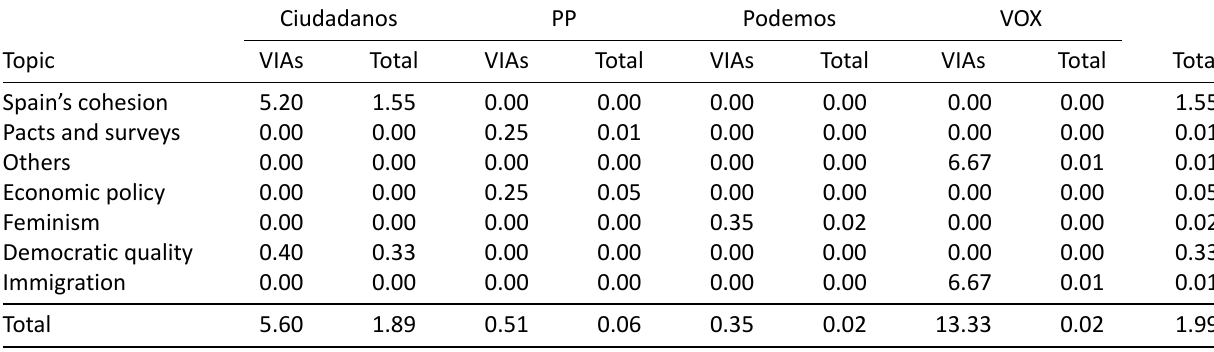
Figure 2. Reporting and use of disinformation by topic. Table 6. Use of disinformation by political party and by topic